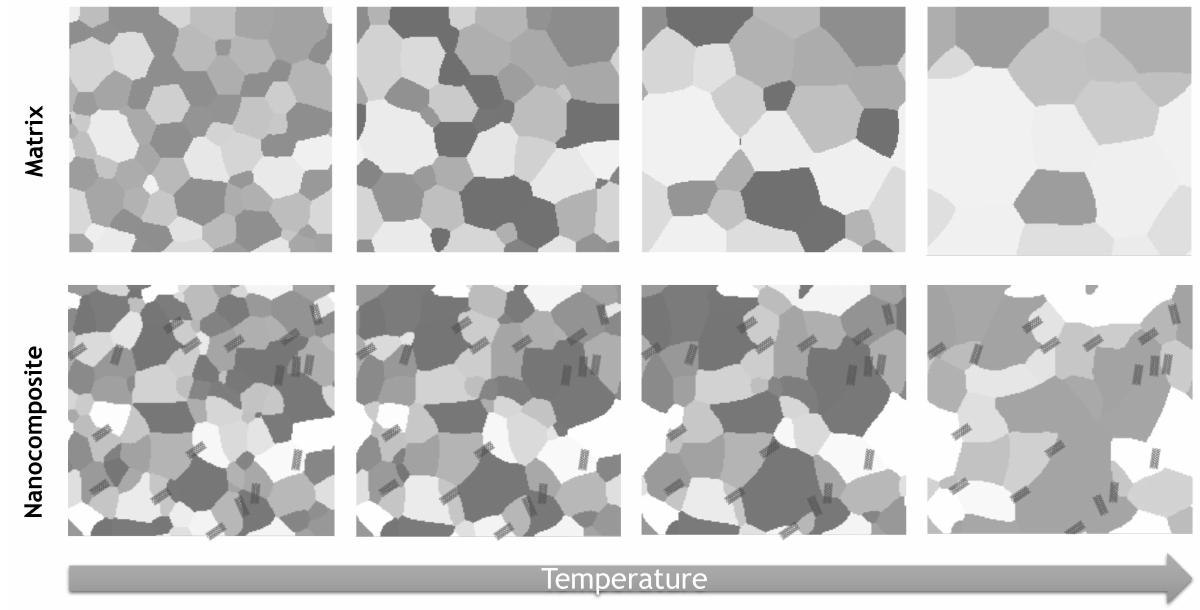
Figure 11. Schematic of the CNTs’ influence during the grain growth of the metal matrix, showing that the grain boundary motion as affected by CNT pinning and rotation induces a final microstructure with a different grain size or/and